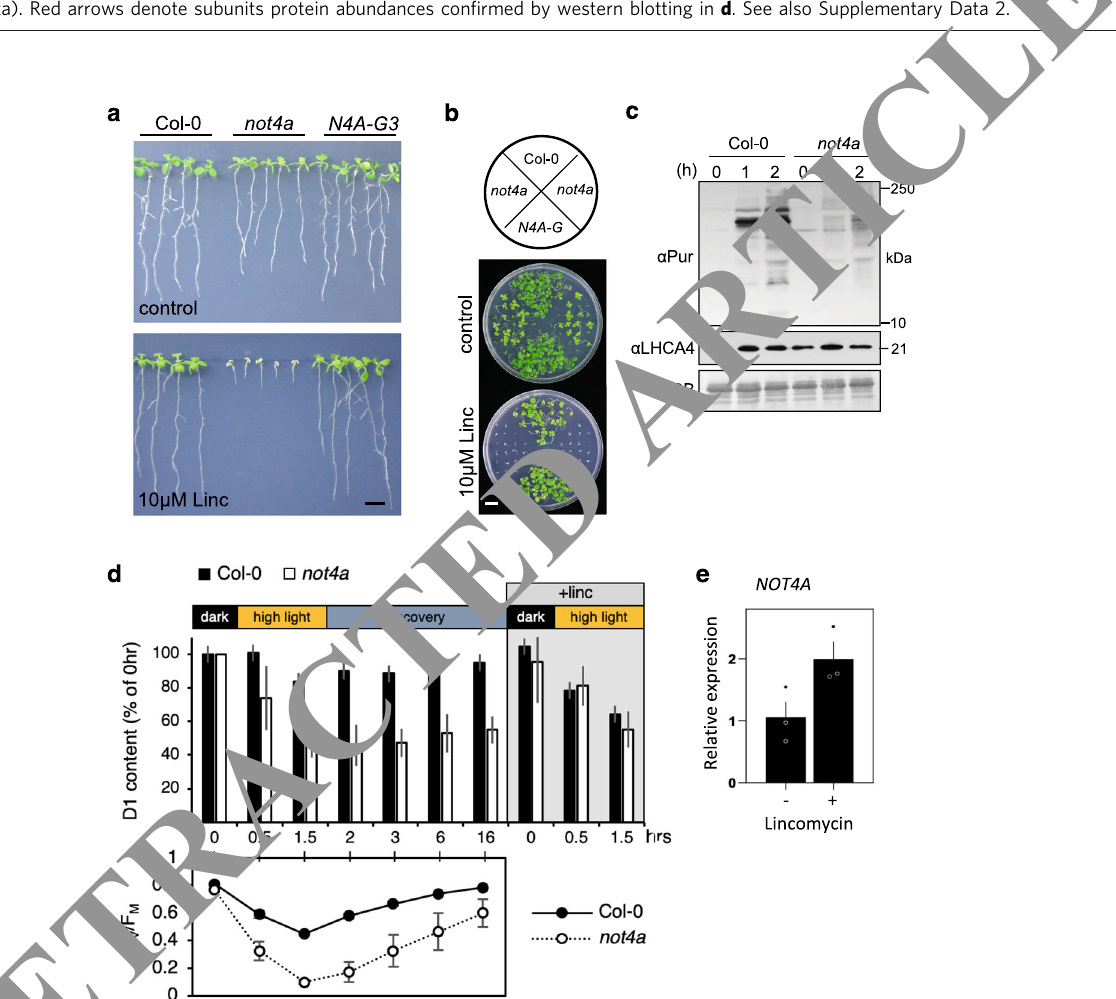
Fig. 3 NOT4A is required for plastid ribosome biogenesis. a , b Volcano plots showing differential abundance of total and plastid-localised proteins in not4a vs wild-type (Col-0) 30-day old-rosettes: x -axis, log2-Fold Change values of protein abundances in not4a versus wild-type; y -axis, log10-p values from a two-sided t -test. For the plastid-speci fi c graph, photosynthetic and plastid ribosome proteins are highlighted in green and blue, respectively. The number of quanti fi ed proteins and their overlap are shown in Venn diagrams above each plot. The top 8 differentially accumulated proteins are labelled (UP: ALDH2C4/AT3G24503, VHA-E3/AT1G64200, HCF101/AT3G24430, AT2G42170, NS1/AT4G17300 and DOWN: AT3G47070, RPS2/ ATCG00160, ADK2/AT5G03300). c Histogram of summed protein amounts (ppm) of MapMan 90 annotated functional groups. Asterisk highlights 30 S ribosome group that is signi fi cantly depleted in not4a vs Col-0. Error bars = ±SEM. n = 3 biological replicates. p = 3.33E-08, students t -test, two tailed. d Western blot determination of relative protein abundance of 30 S subunits (RPS1 and RPS7) and 50 S subunits (RPL2 and RPL4) in Col-0 and not4a , with coomassie blue (CBB) staining to show comparable protein loading. Blots were repeated at least three times with similar results. e Relative amounts (ng/ µ l) of 50 S (23 s and 23 sb) and 30 S (16 s) plastid rRNAs in not4a vs Col-0. Values are quanti fi ed from Tapestation data shown in Supplementary Fig. 5, following normalisation to cytosolic 18 s rRNA. Error bars = ±SEM. n = 3 independent biological replicates. * p = 0.0446, ** p = 0.0037, students t -test, two tailed. f Heatmap showing relative transcript and protein fold-changes for 50 S and 30 S plastid ribosome subunits in not4a vs Col-0 (from RNA-seq and